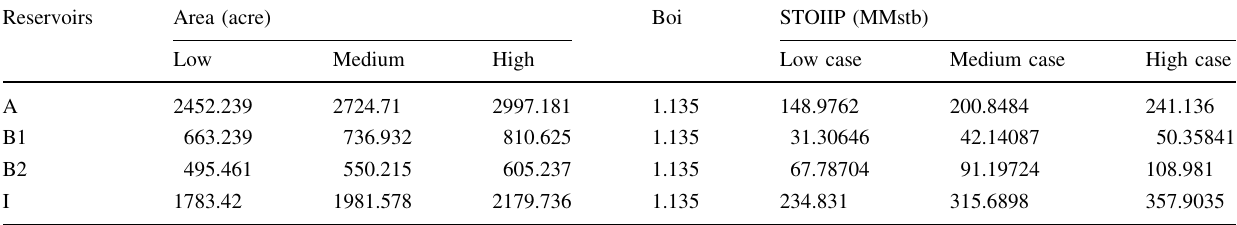
Fig. 9 Range of STOIIP (MMstb) for reservoirs-A, B